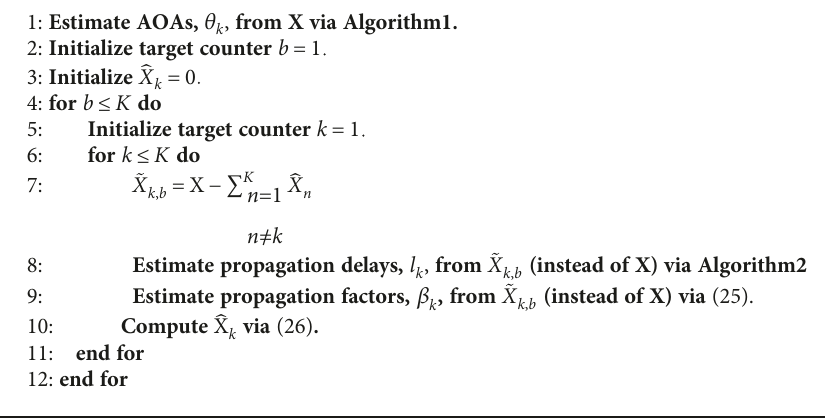
Algorithm 3: Localization algorithm.